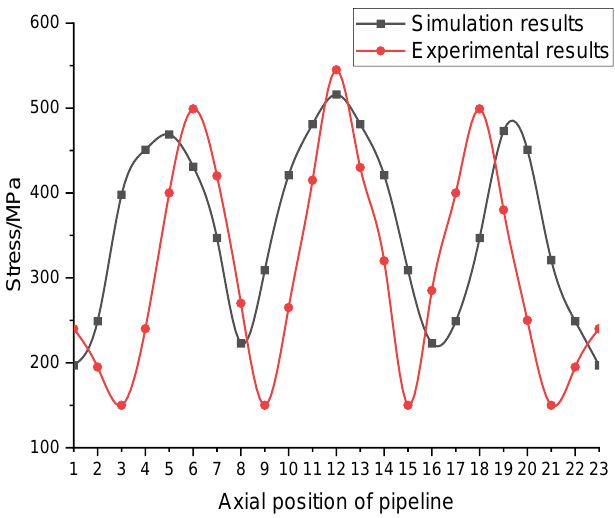
Figure 9. Schematic illustration of pipeline model